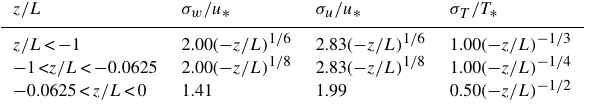
Table 2. Dependence of the integral turbulence characteristics for wind components w , u and temperature T on the stratification (Fo- ken and Wichura, 1996; Foken et al., 1991). z/L σ w /u